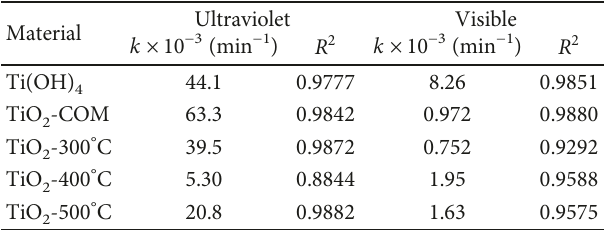
Table 2: Photocatalytic reaction constants of the MB degradation. Material